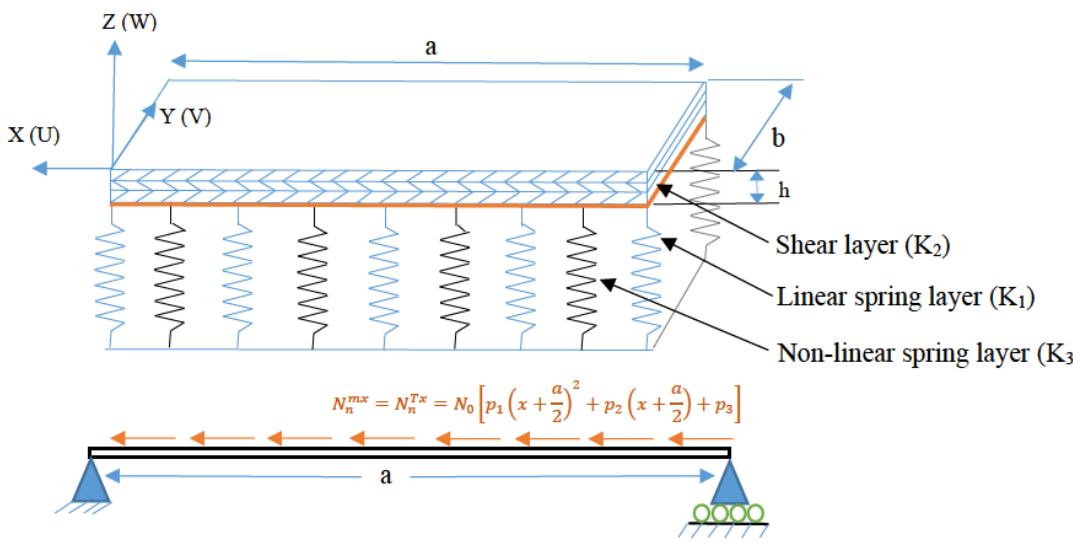
Figure 1: Geometrical configuration of MWCNTRCLB under variable polynomial inplane loading